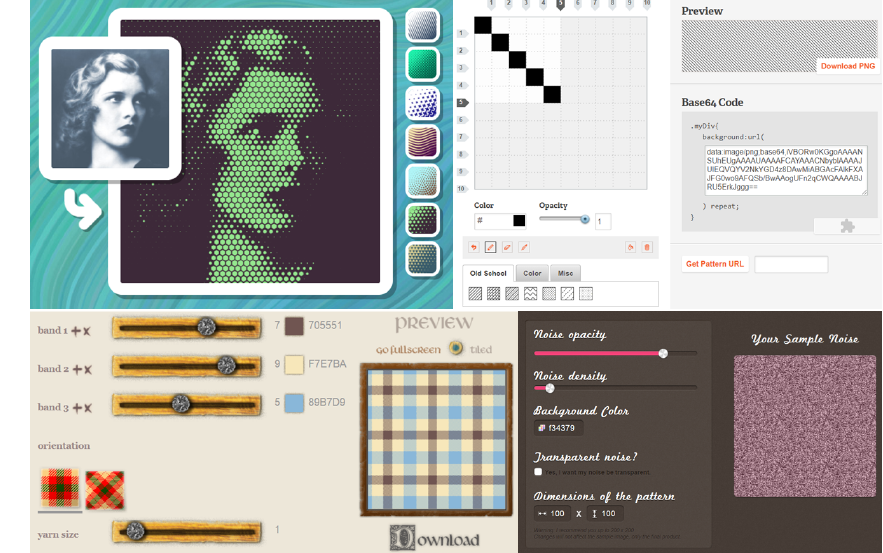
Figure 3. Outputs and interfaces of pattern generators.